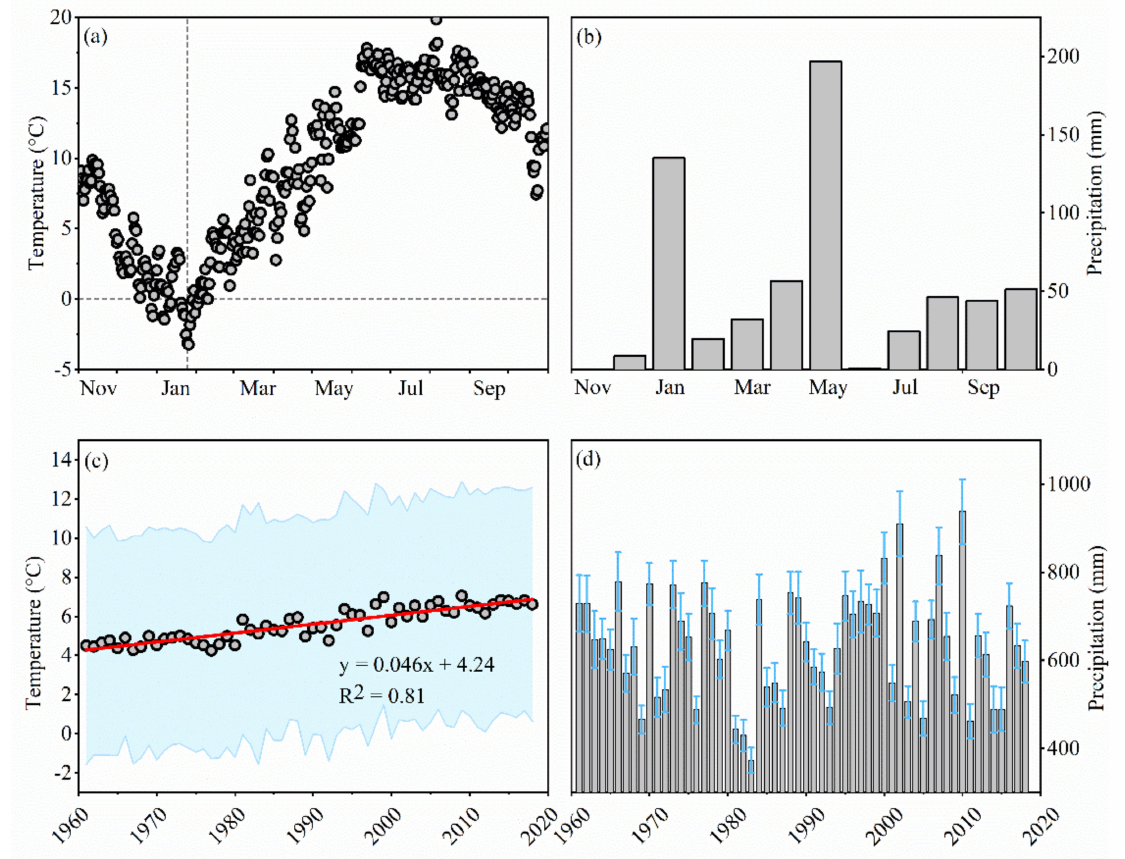
Figure 9. ( a , b ) The temperature and precipitation in glacier terminus from November 2019 to November 2020. ( c , d ) The tendencies of temperature and precipitation at Deqin Station from 1960 to 2018; the red line is the tendency of annual temperature, and the blue area and blue line are the standard deviation of temperature and